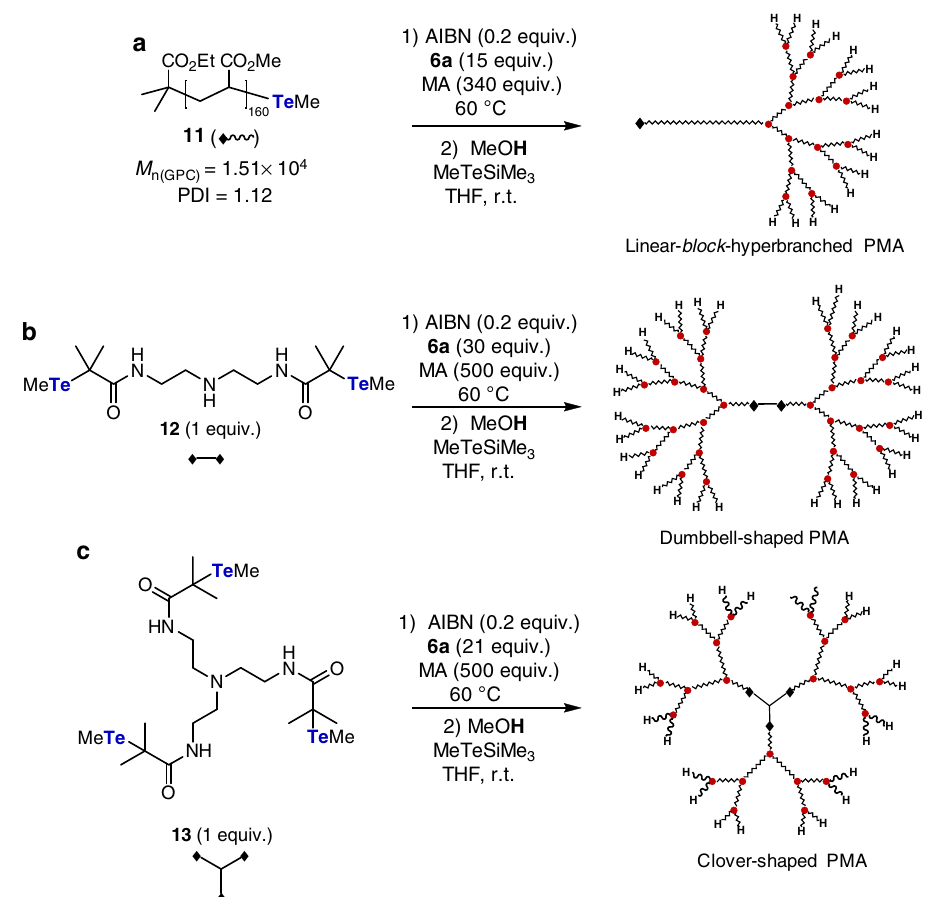
Fig. 5 Synthesis of hyperbranched PMA with different molecular structures. a Linear- block -hyperbranched PMA, b dumbbell-shaped PMA, and c clover- shaped